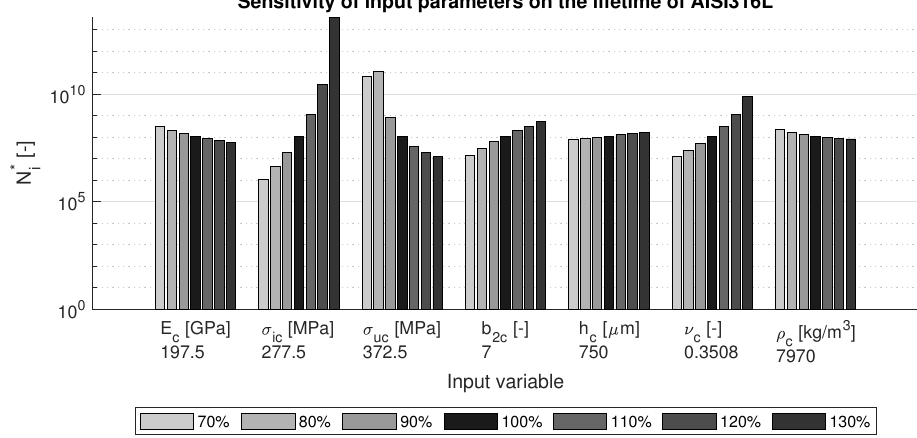
Figure 5. Sensitivity of variations in the input parameters on the lifetime of AISI 316L steel. In order to study the effects of the constants a 1 and a 2 , the VN curve is required. This curve plots the number of impacts against the impact velocity and is generally used to display fatigue life. The VN curves for variations in the constants a 1 and a 2 are given in Figure 6. It can be seen that the effect of a 1 on the coating life is very limited. The influence of a 2 is more prominent: the graph shows significant changes in coating lifetime and the slope of the fatigue curve. By changing the ratio of σ e , c to σ 0, c , the curve can be shifted along the x -axis. This is a common approach for fitting the Springer model to rain erosion test data.